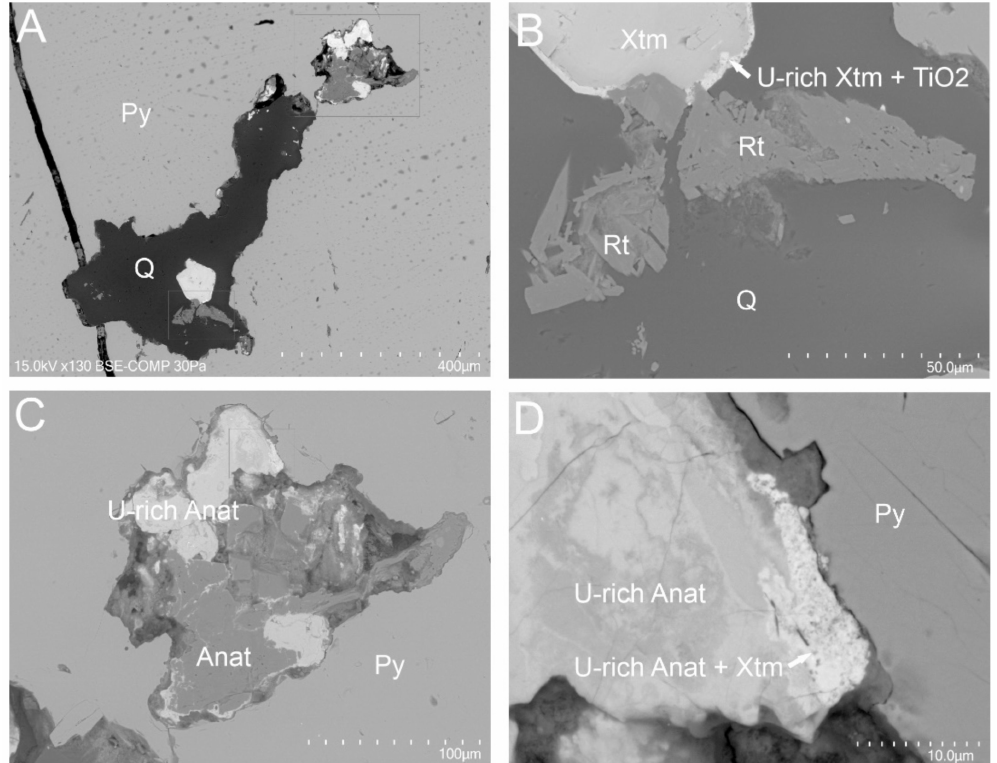
Figure 7. SEM back-scattered images of inclusions hosted in Py-III and associated quartz. ( A ) Pyrite and associated quartz with inclusions—general view, ( B ) Inclusion of xenotime with U-rich rim and anatase, ( C ) Secondary inclusion of anatase in pyrite—general view, ( D ) Uranium-enriched fragments of anatase inclusion in pyrite.